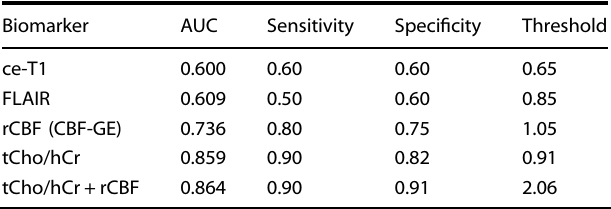
Table 2. ROC analysis of the imaging biomarkers Biomarker